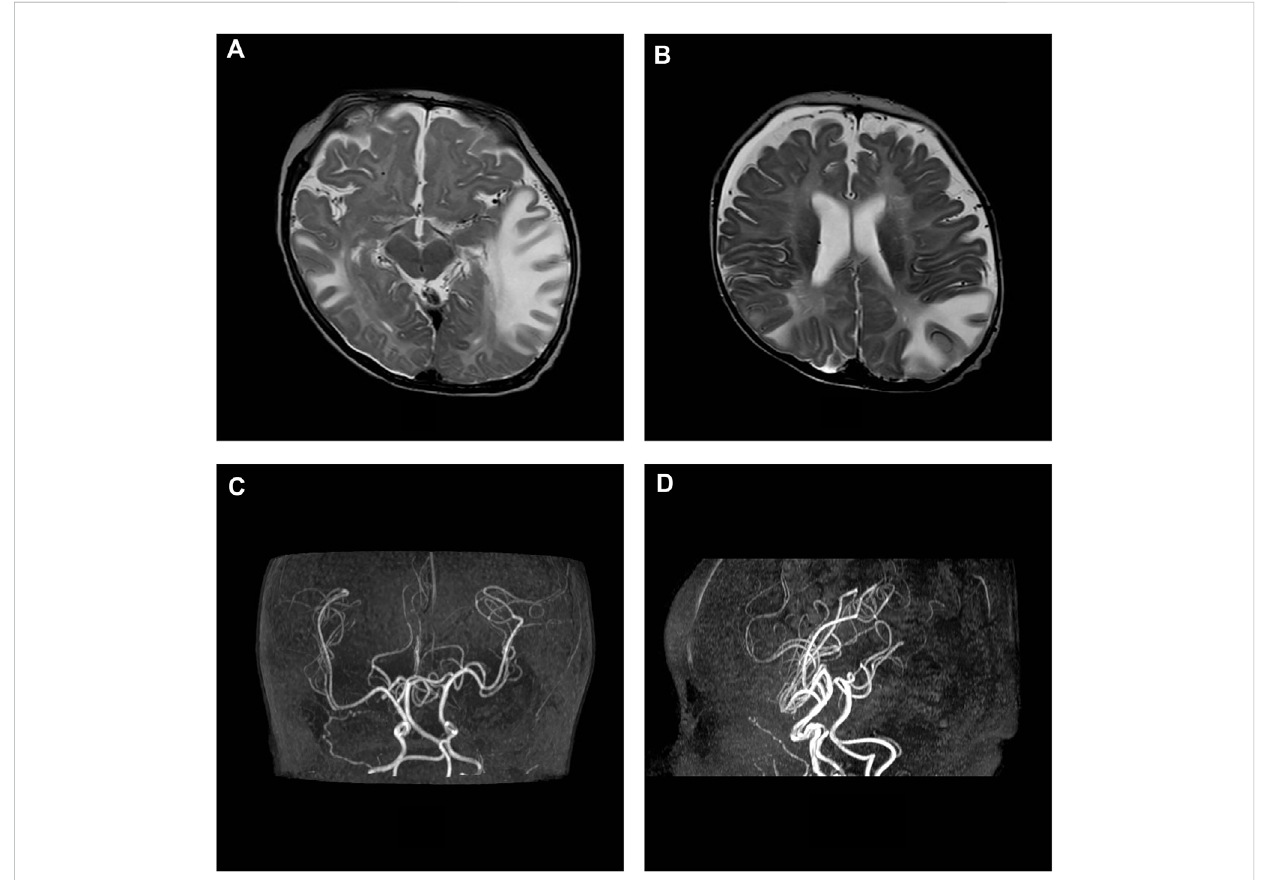
FIGURE 2 MRI axial T2-w images show asymmetric tumefactive lesions of thetemporal and parietal white matter, increasein size of subarachnoid spacesand subtle frontal bilateral subdural collections (A, B) . On AngioRM sequence intracranial arteries tortuosity is evident (C, D)